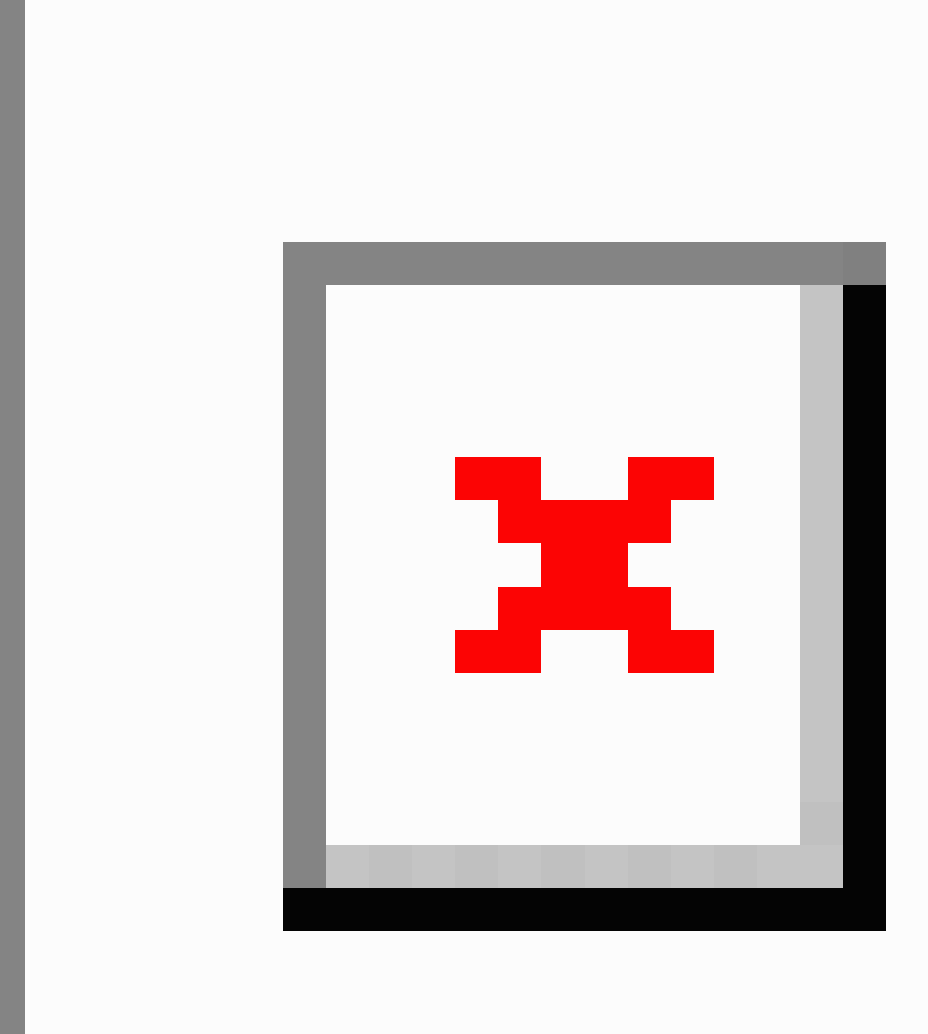
Figure 1. Stills of the SUPR educational videos: (1) testimonial video in which peers talk about their experiences with hearing loss; (2) instruction video on cleaning and maintenance of hearing aids; (3) video on how to apply effective communication strategies in a group setting; (4) instruction video on using assistive listening devices; (5) video on how to apply effective communication strategies in a one-to-one conversation; and (6) instruction video on how to insert hearing